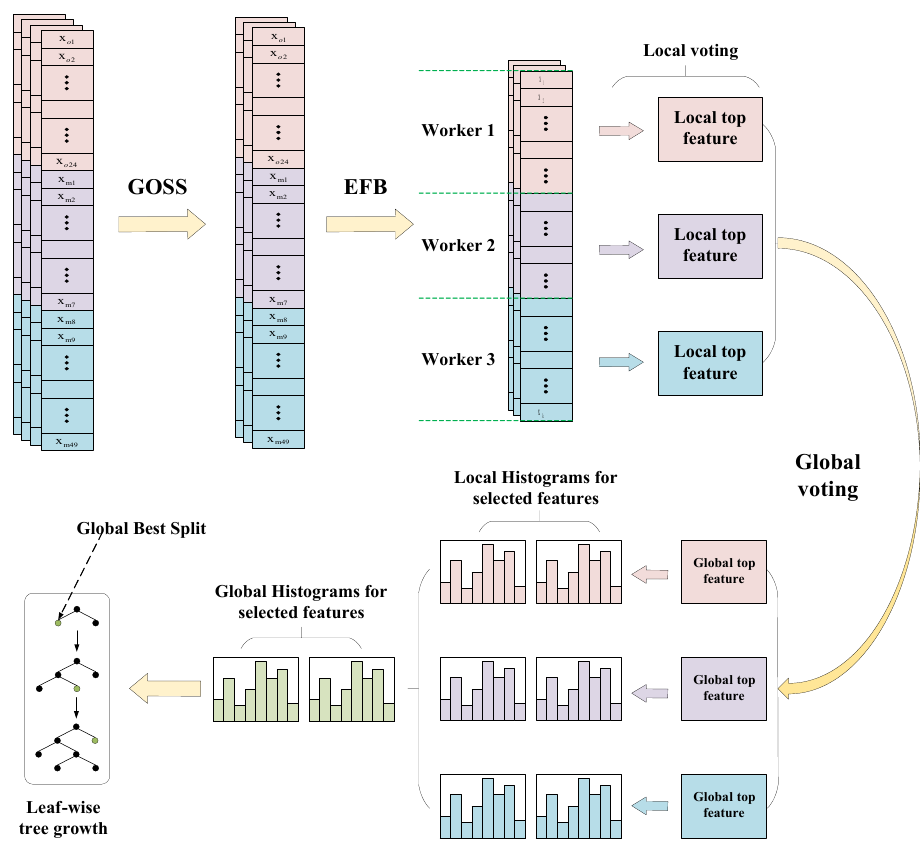
Figure 3. Schematic illustration of the lightGBM model.